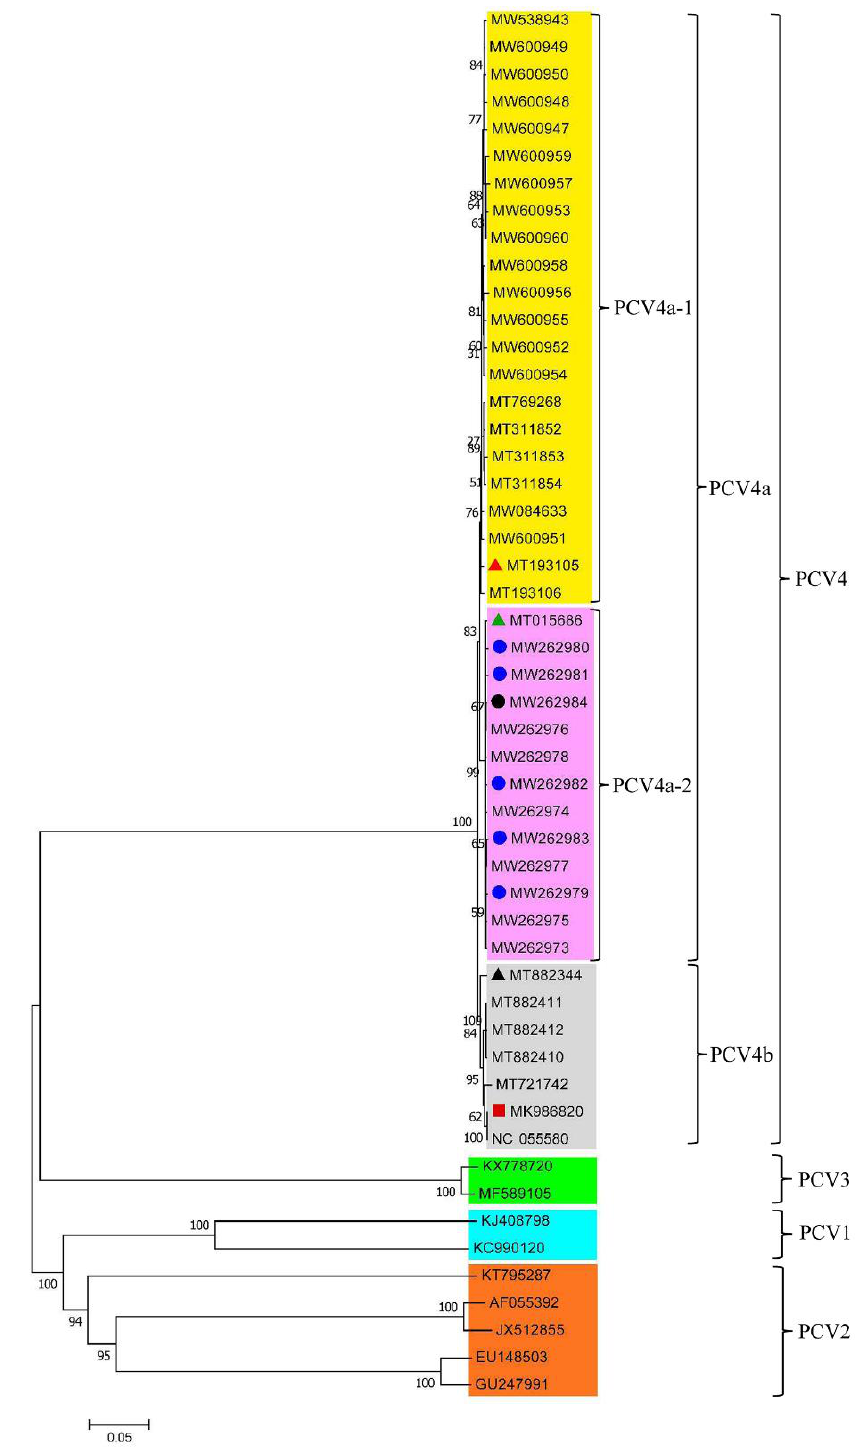
Figure 2. Phylogenetic tree of the 50 PCV strains. The red triangle is the representative strain of cluster 1 (PCV4a-1); the green triangle is the representative strain of cluster 2 (PCV4a-2); the blue circle is the PCV4 strain isolated from raccoon dogs; the black circle is the PCV4 strain isolated from foxes; the black triangle represents the Korean PCV4 strain; the red square is the PCV4 representative strain.